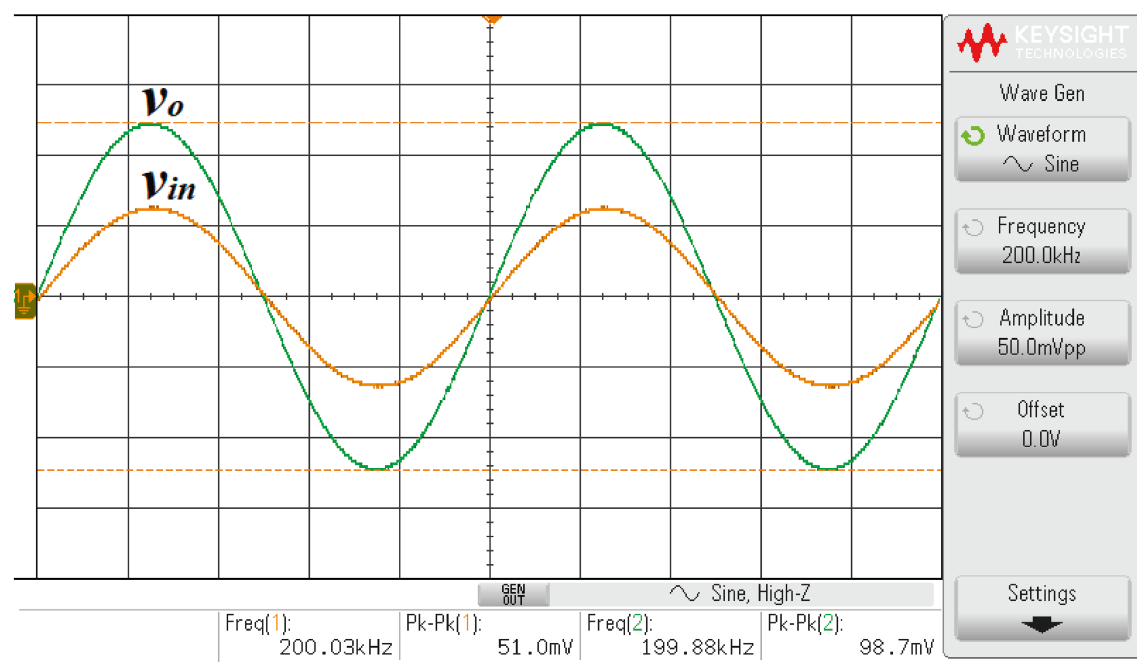
Figure 10: Measured input and output waveform of the BP